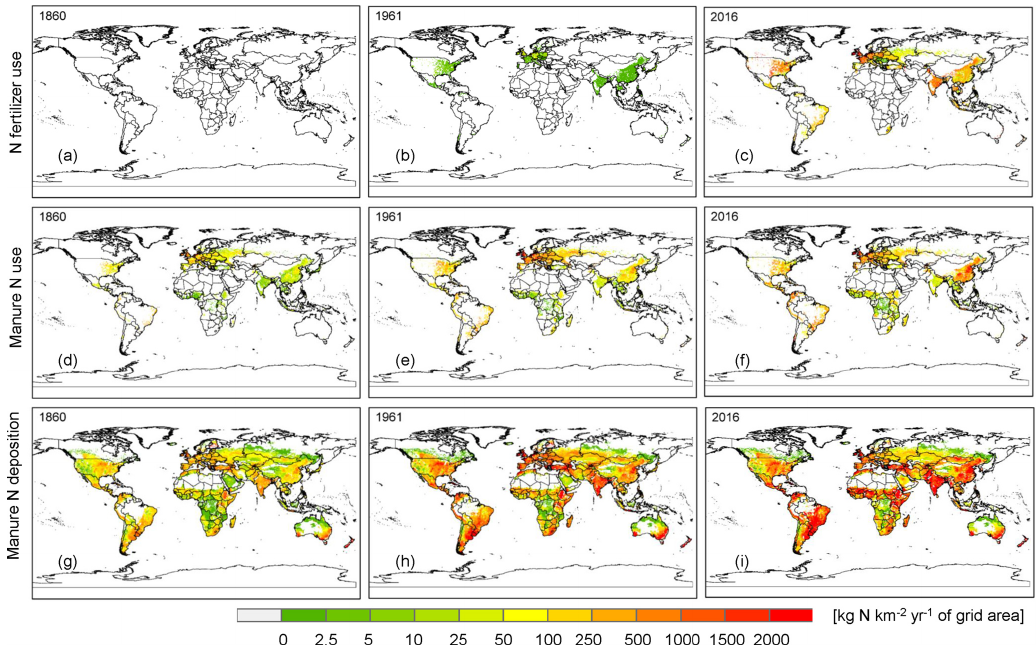
Figure 4. Spatial patterns of N input rates in global pastures and rangelands in 1860, 1961 and 2016: (a, b, c) N fertilizer application rates, (d, e, f) manure N application rates and (g, h, i) manure N deposition rates.